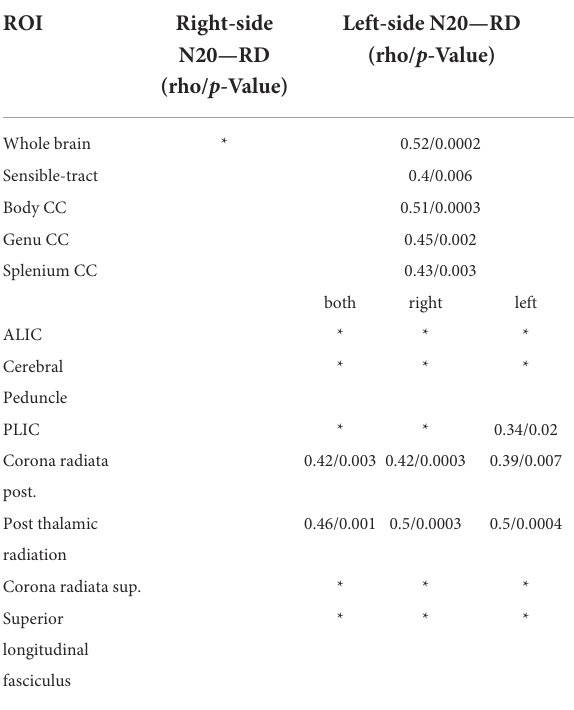
TABLE 4 Shown are the Spearman-Correlation values of mCCT for selected ROIs and the two DTI-derived Parameters FA and